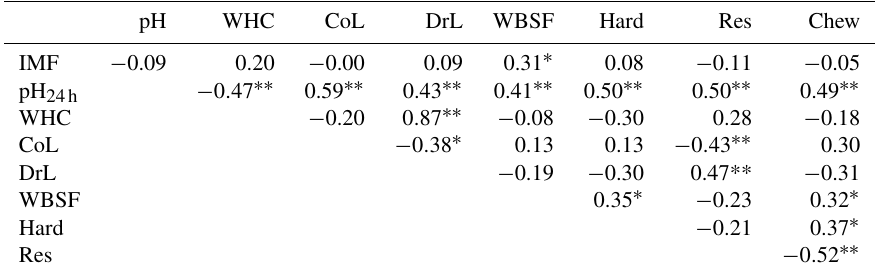
Table 3. The Pearson correlations between intramuscular fat, pH, water-holding capacity, cooking loss, drip loss, and various instrumental quality values of